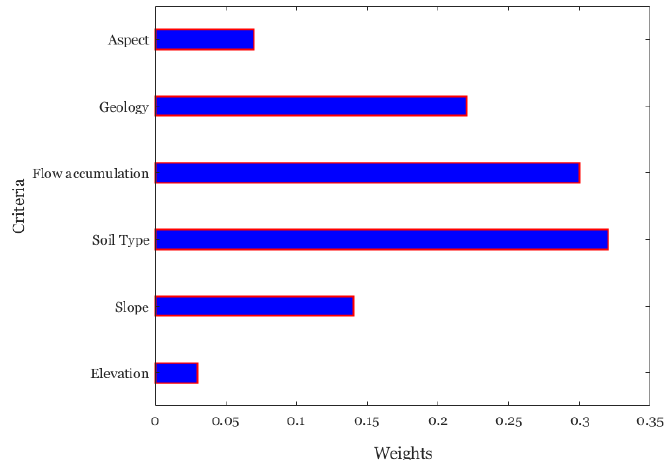
Figure 9. Parameters analyzed to detect the existing road network and develop proposals of alternatives routes (normalized weights).